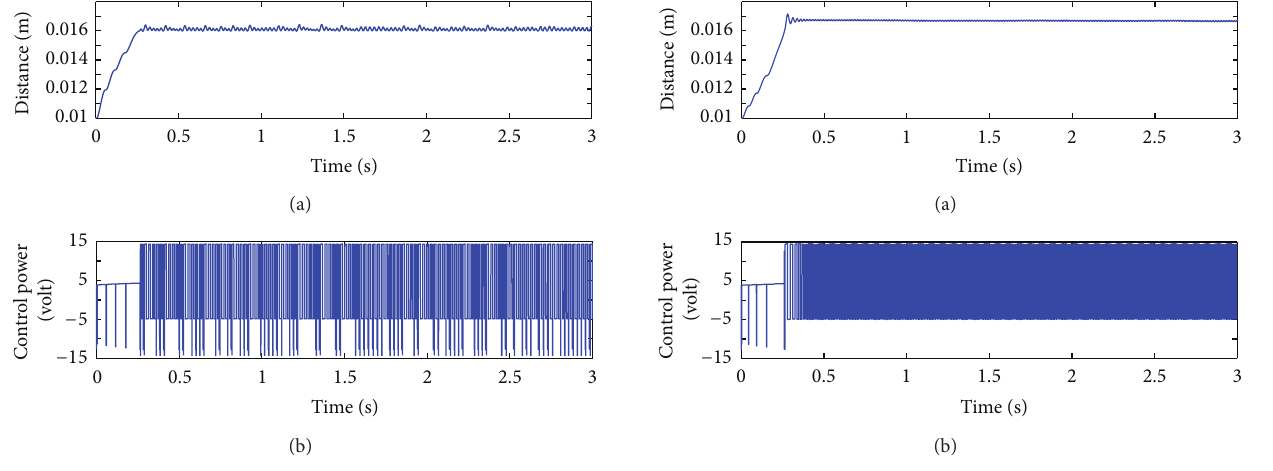
Figure 5: Simulation result for Maglev without disturbance (in which it goes from 10 to 16mm). (a) Distance between train and rail, (b) control signal.